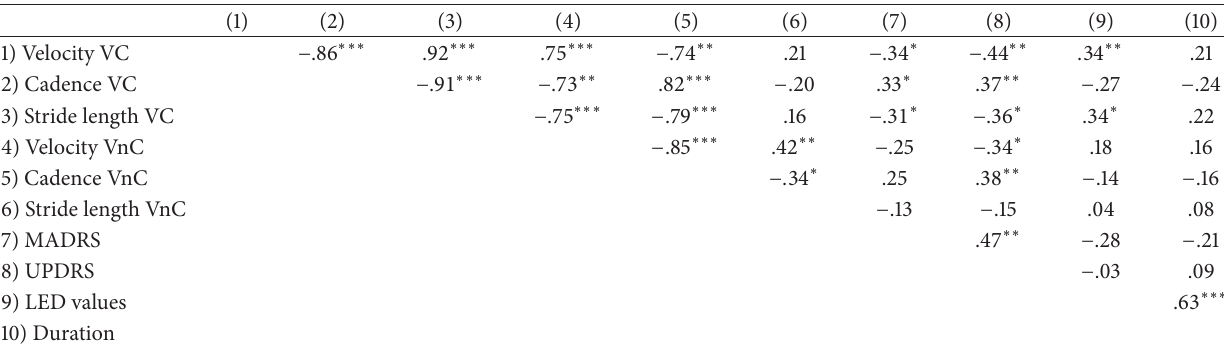
Table 3: Persons’ correlation of gait characteristics and depression scale in Parkinson’s disease group in two conditions (VC = visually controlled condition; VnC = visually noncontrolled condition): MADRS (Montgomery-˚Asberg Depression Rating Scale); UPDRS (Unified Parkinson’s Disease Rating Scale); LED values; duration of